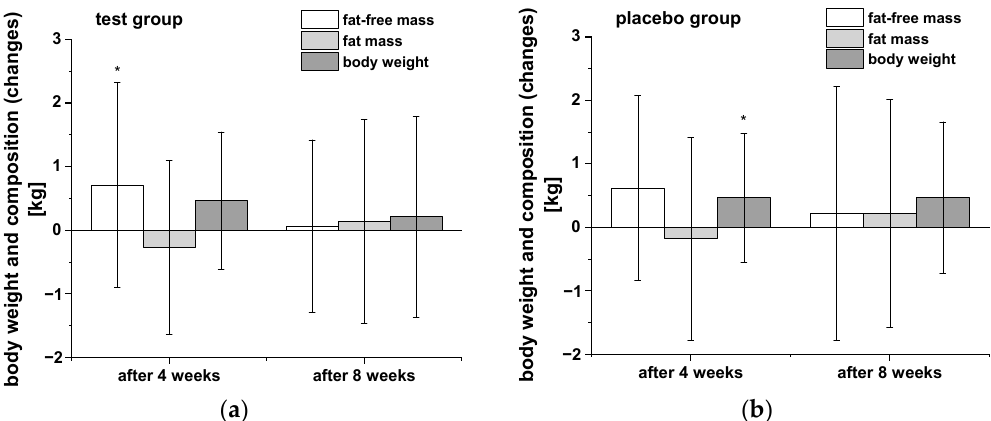
Figure 1. The changes in body weight, fat-free mass, and body fat of participants in both groups during the intervention in comparison to the washout period: ( a ) test group (n = 18), ( b ) placebo group (n = 18). Data are presented as mean values and SD of differences. Significant differences in body weight and composition relative to the washout period: * p < 0.05. Table 4. The blood lipid profiles and lipase activity of the participants throughout the study. Data are presented as mean values and SD. Significant differences in comparison to the washout period: ** p <